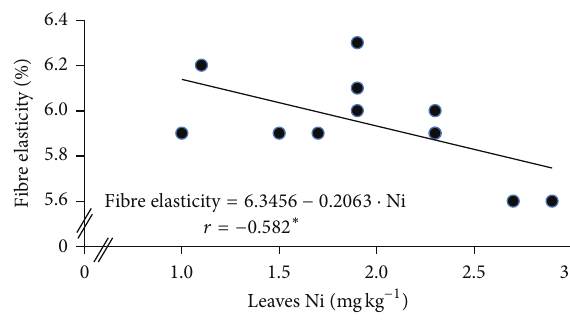
Figure 8: Regression curve between Ni content of leaves and fibre elasticity in the 2006 experiment ( ∗ 𝑝 < 0.05 ).